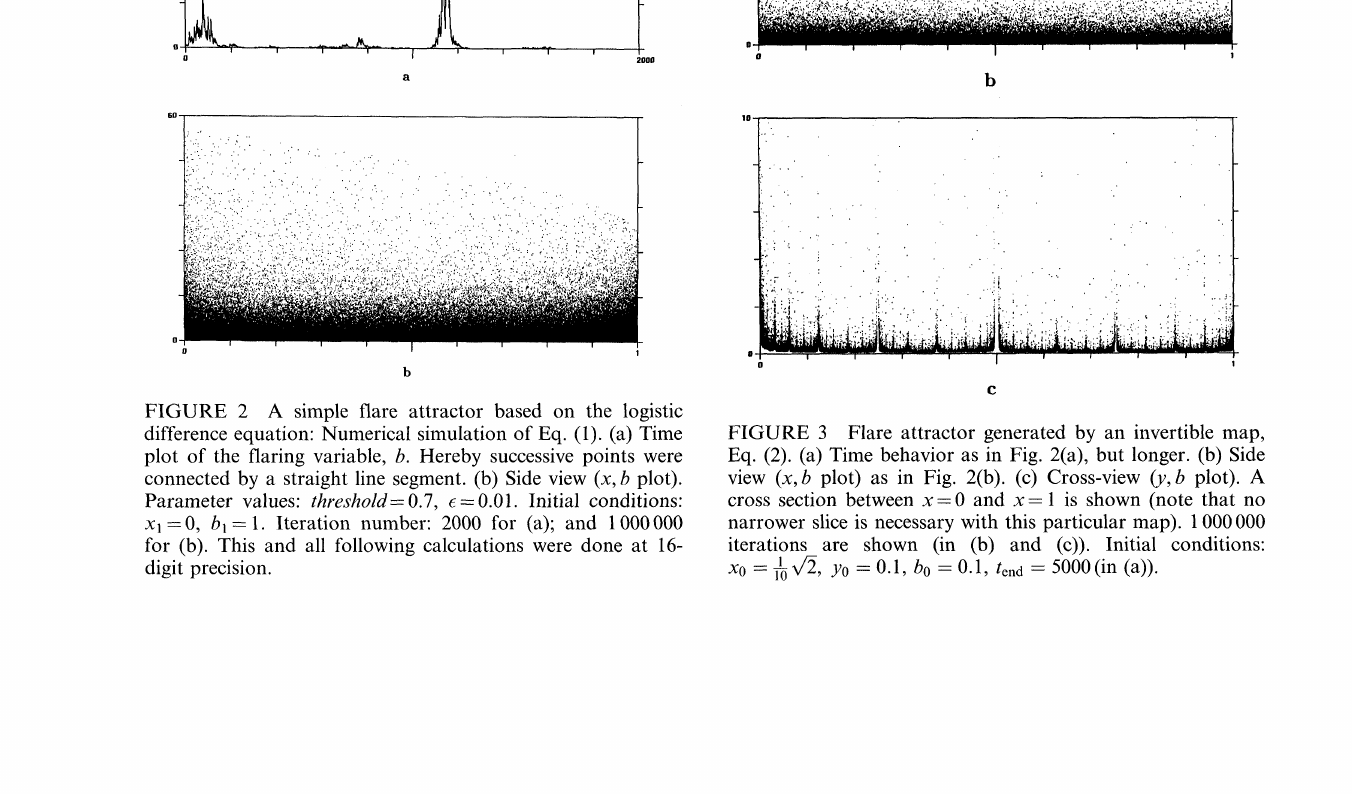
Basic mode of action of a flare attractor. A chaotic subsystem "forces" a nonlinearly responding autocata- lytic unit (schematic drawing).